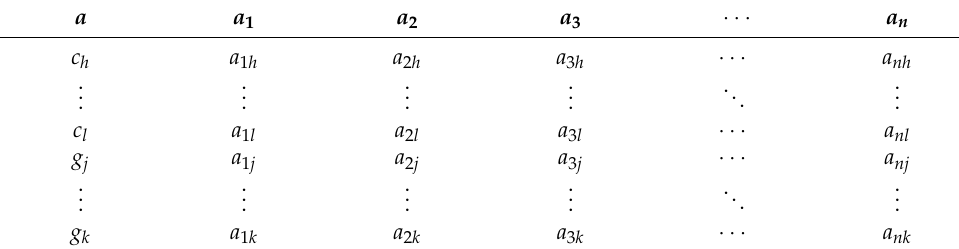
Table 1. Evaluation matrix, considering alternatives under qualitative and quantitative criteria.